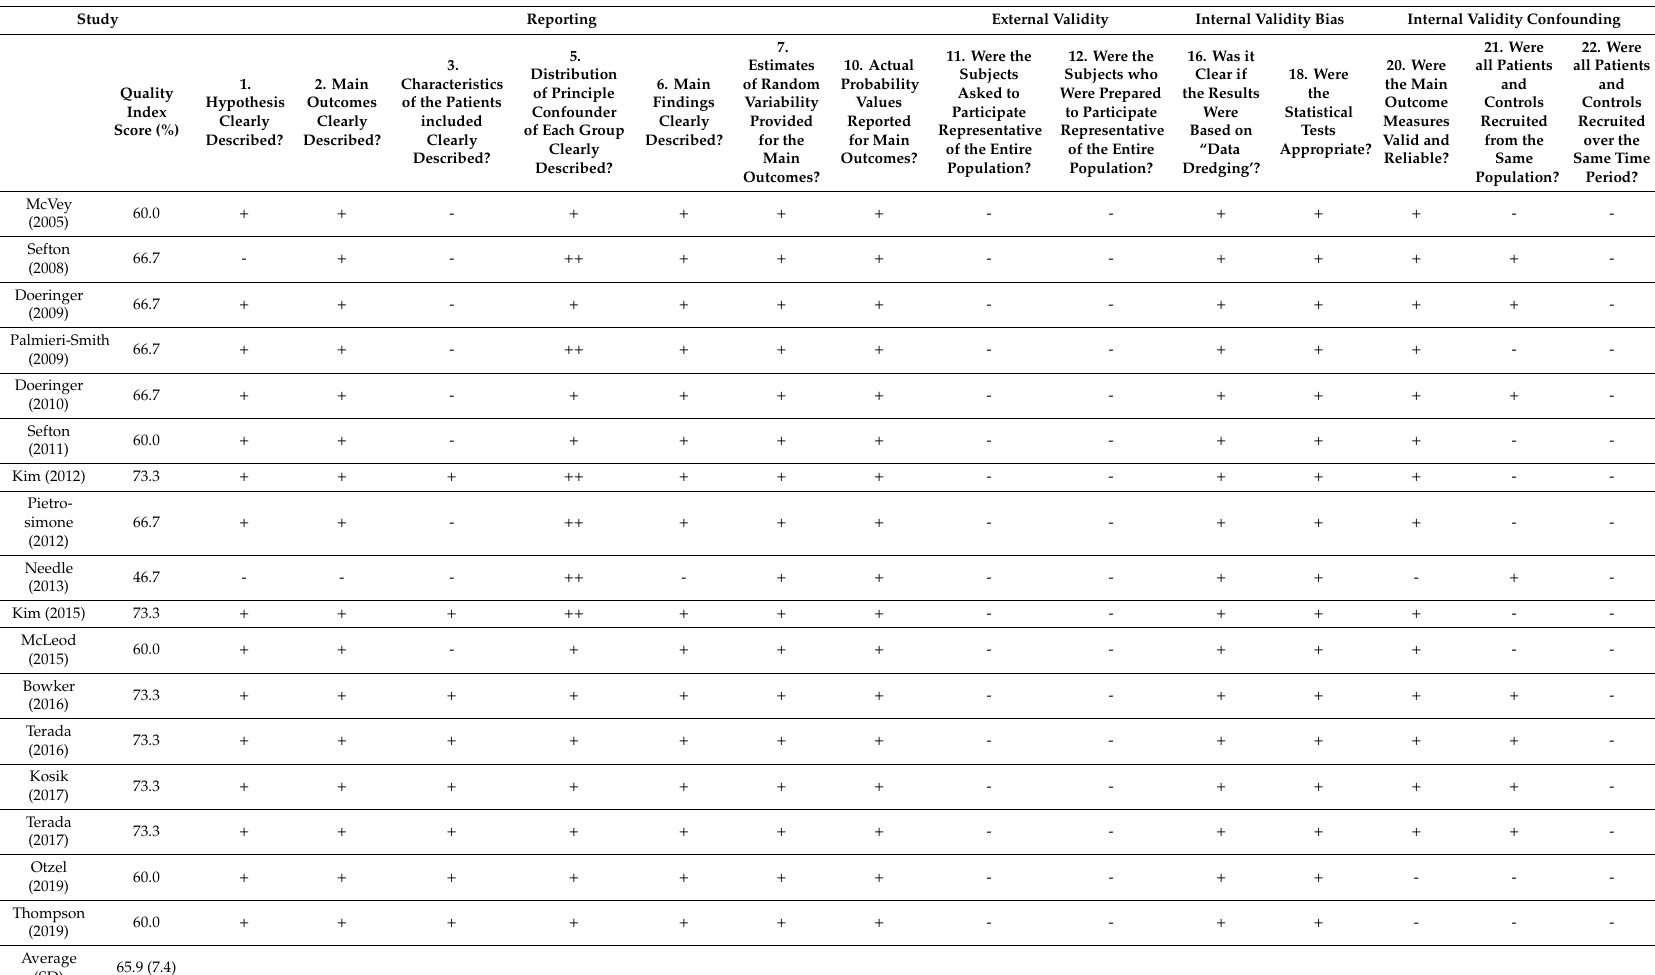
Table 2. Quality assessment of included